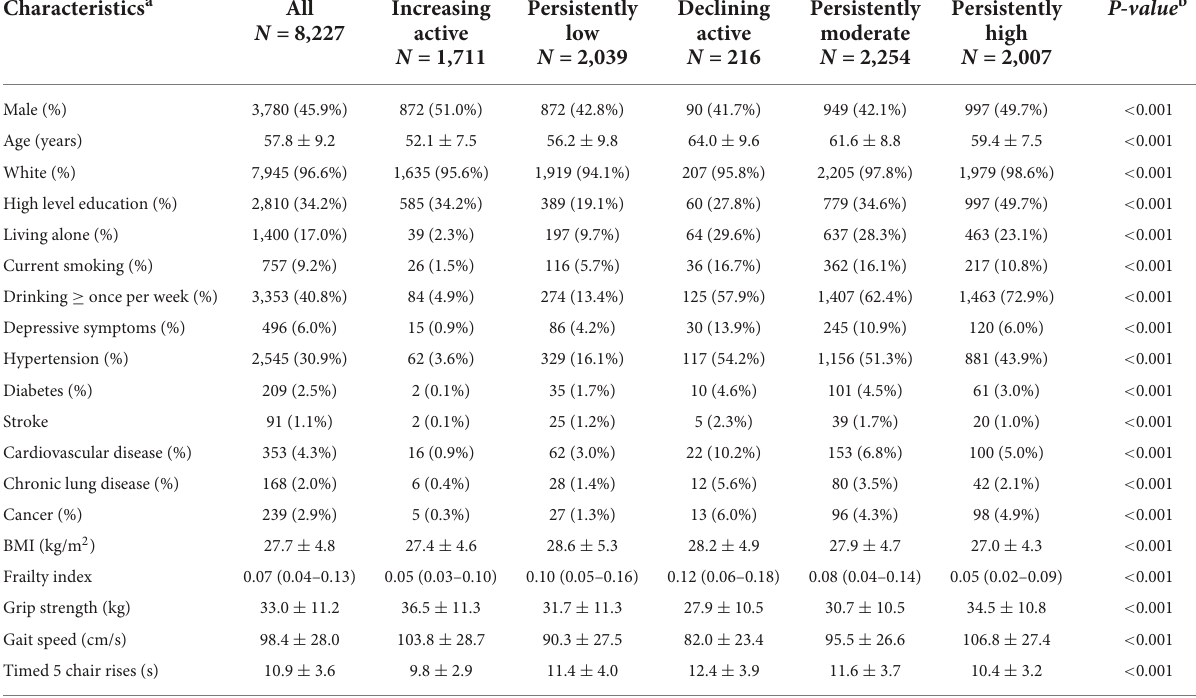
TABLE 1 Baseline characteristics of study population according to physical activity